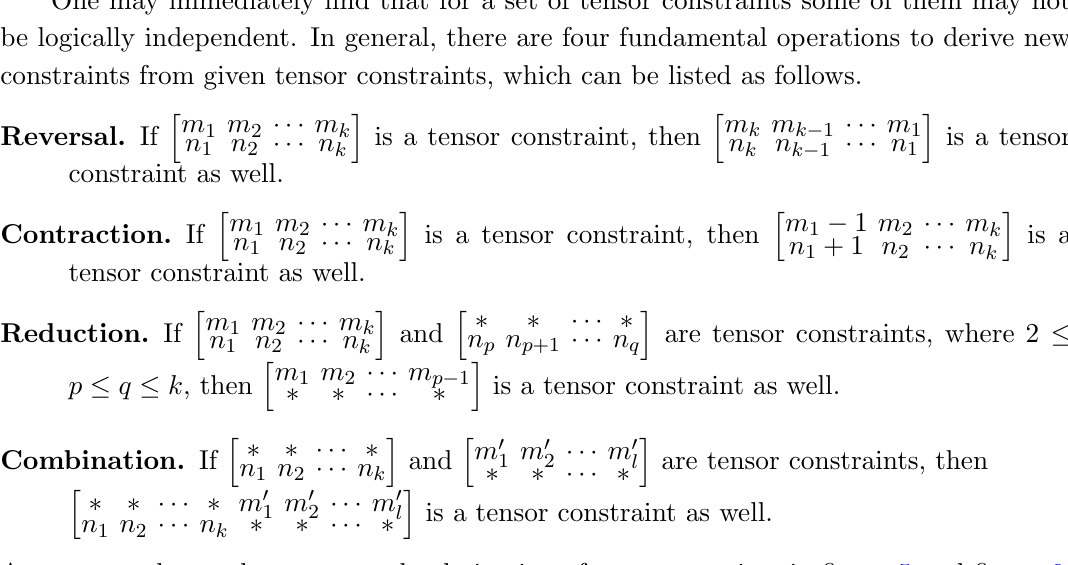
Figure 4 . Multi-tensor constraint constructed by open tensor chain